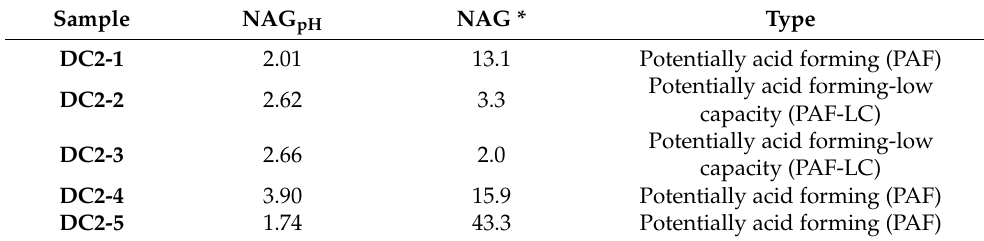
Table 3. NAG classification of the samples from DC2